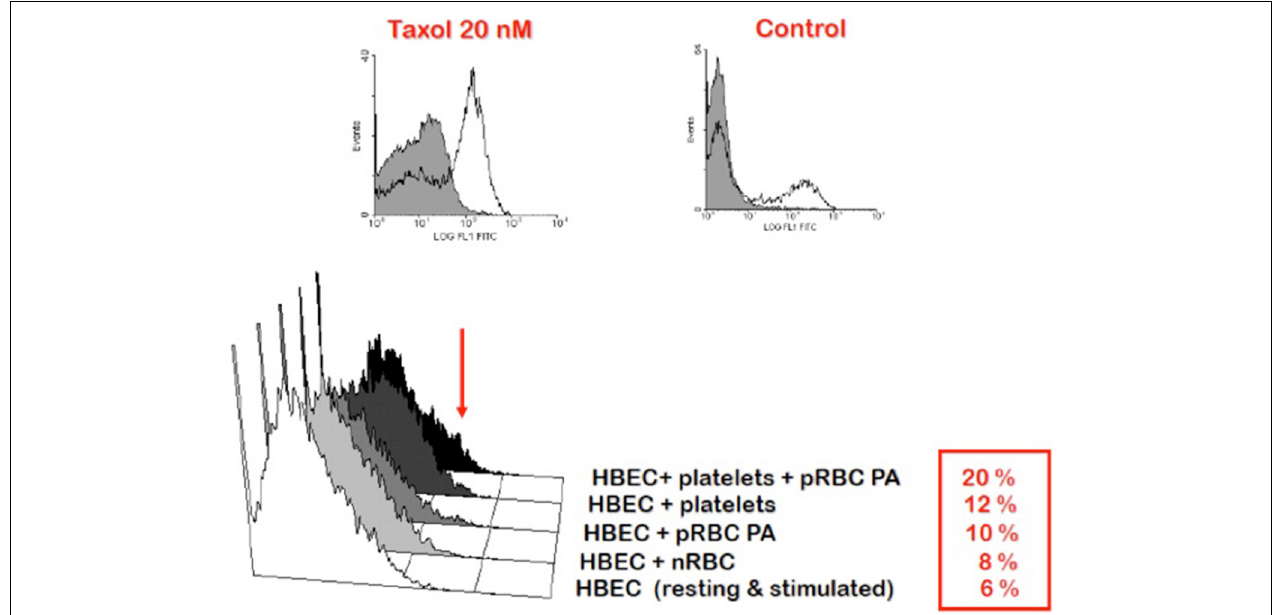
FIGURE 4 | Enhancement of platelet-mediated endothelial cell apoptosis after IFN- γ stimulation. HBEC were stimulated with IFN- γ overnight prior to addition of platelets and RBC. Taxol treatment of HBEC was used as the positive control. FITC-BrdU nuclear fragmentation was quantified using the APO-Direct Kit (BD Biosciences) and an EPICS-XL flow cytometer (Beckman-Coulter). Results are expressed as percentages of